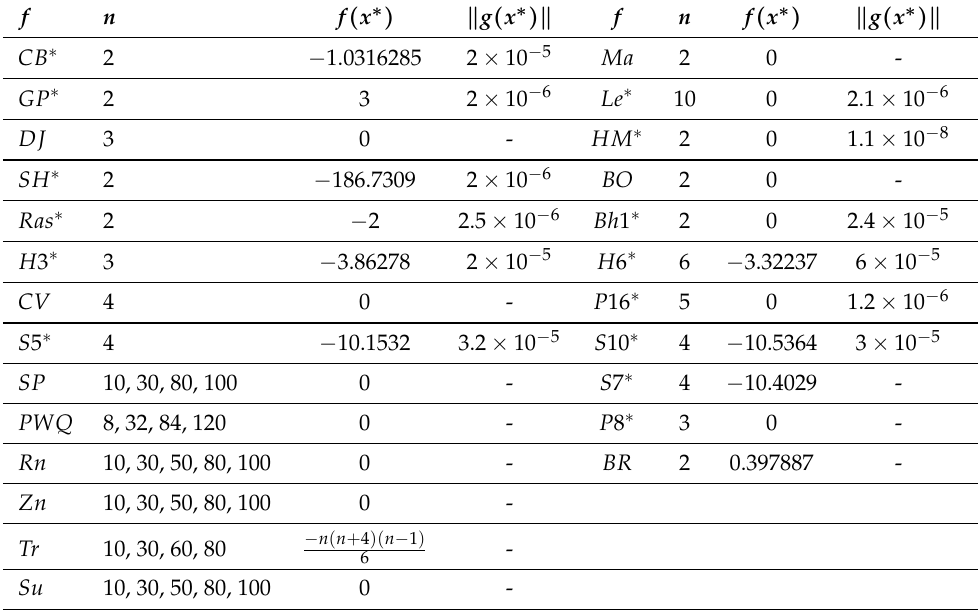
Table 1. Listing of test problems and their exact